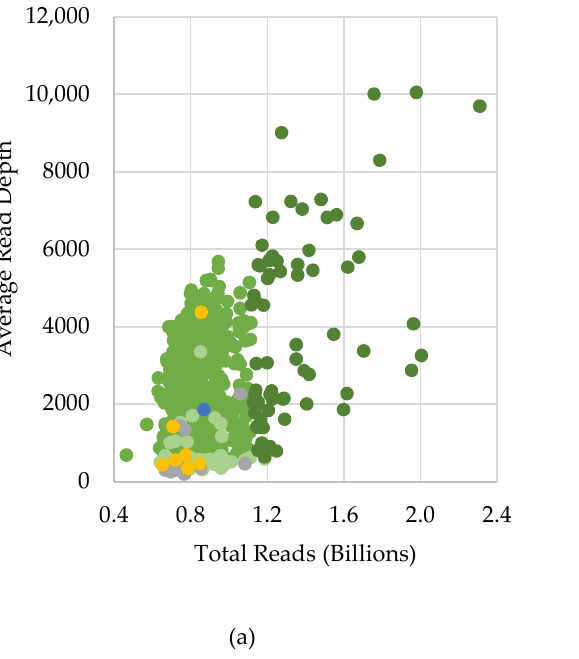
Figure 1. Scatterplots of the correlation between ( a ) total reads (billions) and ( b ) the proportion of mapped reads that mapped to the mtDNA reference genome and the average mtDNA read depth. Samples are plotted based on the category and subclassification: green = complete with less than 1.15 billion total reads ( n = 785), dark green = complete with more than 1.15 billion total reads ( n = 73), light green = nearly complete ( n = 59), gray = incomplete ( n = 17), yellow = mixed ( n = 7), and blue = related ( n = 1).